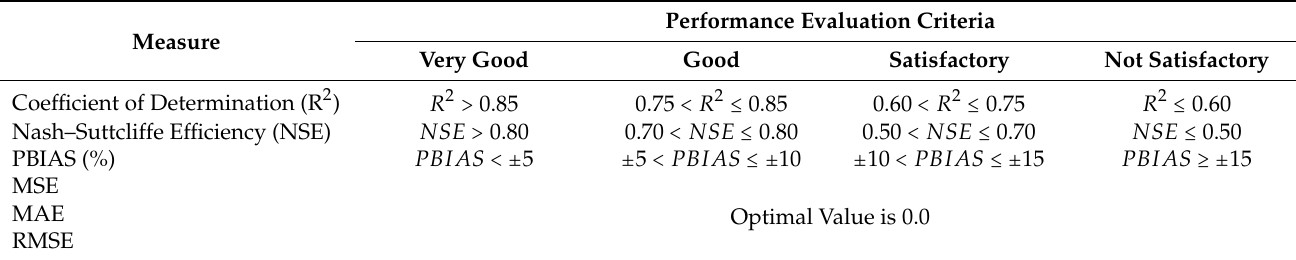
Table 1. Statistical comparison metrics and evaluation